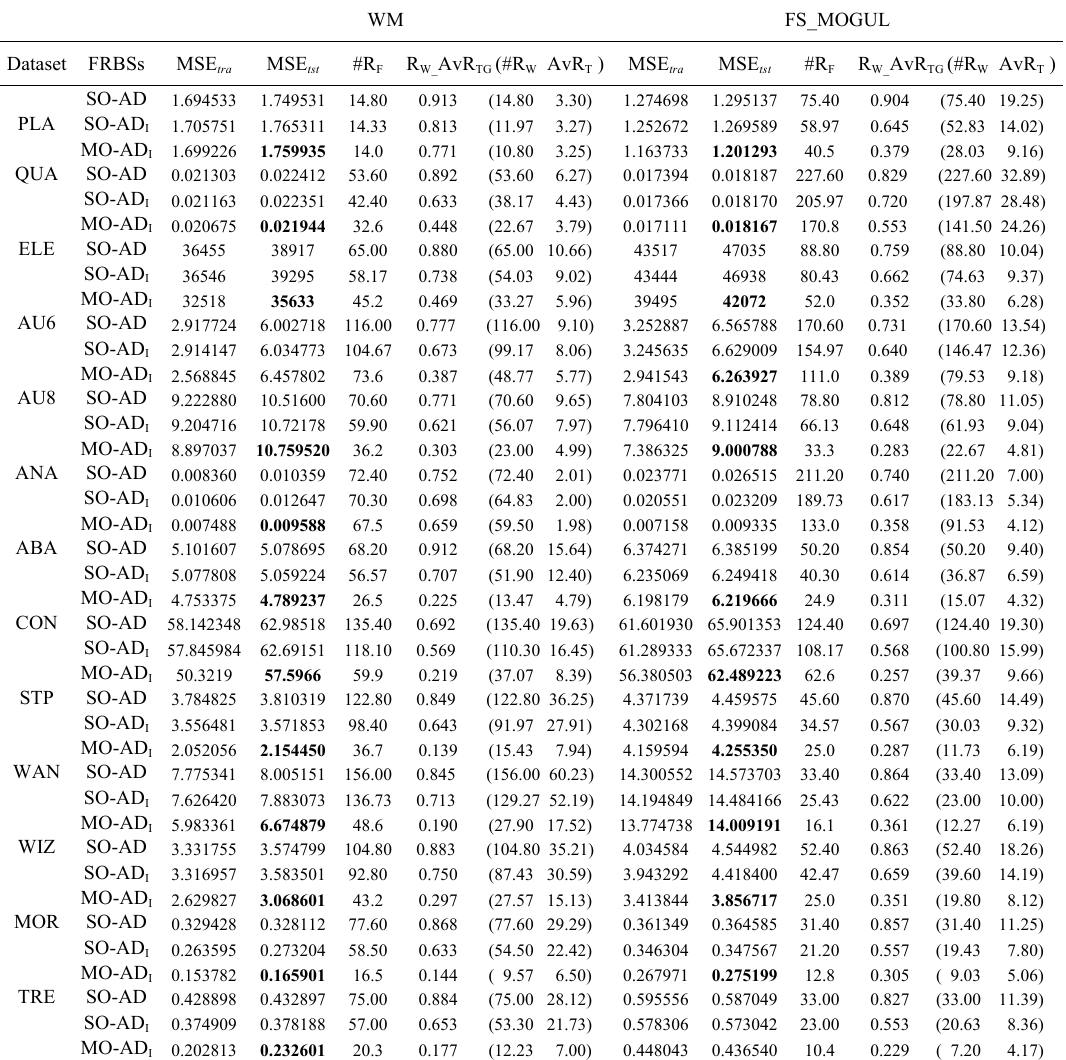
Table 7 Results obtained by standard single-objectives models accuracy oriented (SO-AD) vs single-objectives models with the interpretability improvement mechanism (SO-AD I(0.1-0.9) ),and multi-objective models proposal (MO-AD I(0.1-0.9) ), with both, WM and FS_MOGUL rule bases